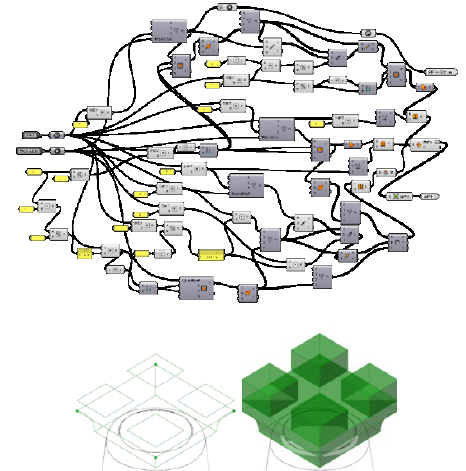
Figure 4. Algorithm battery of Base Generator (top) and real-